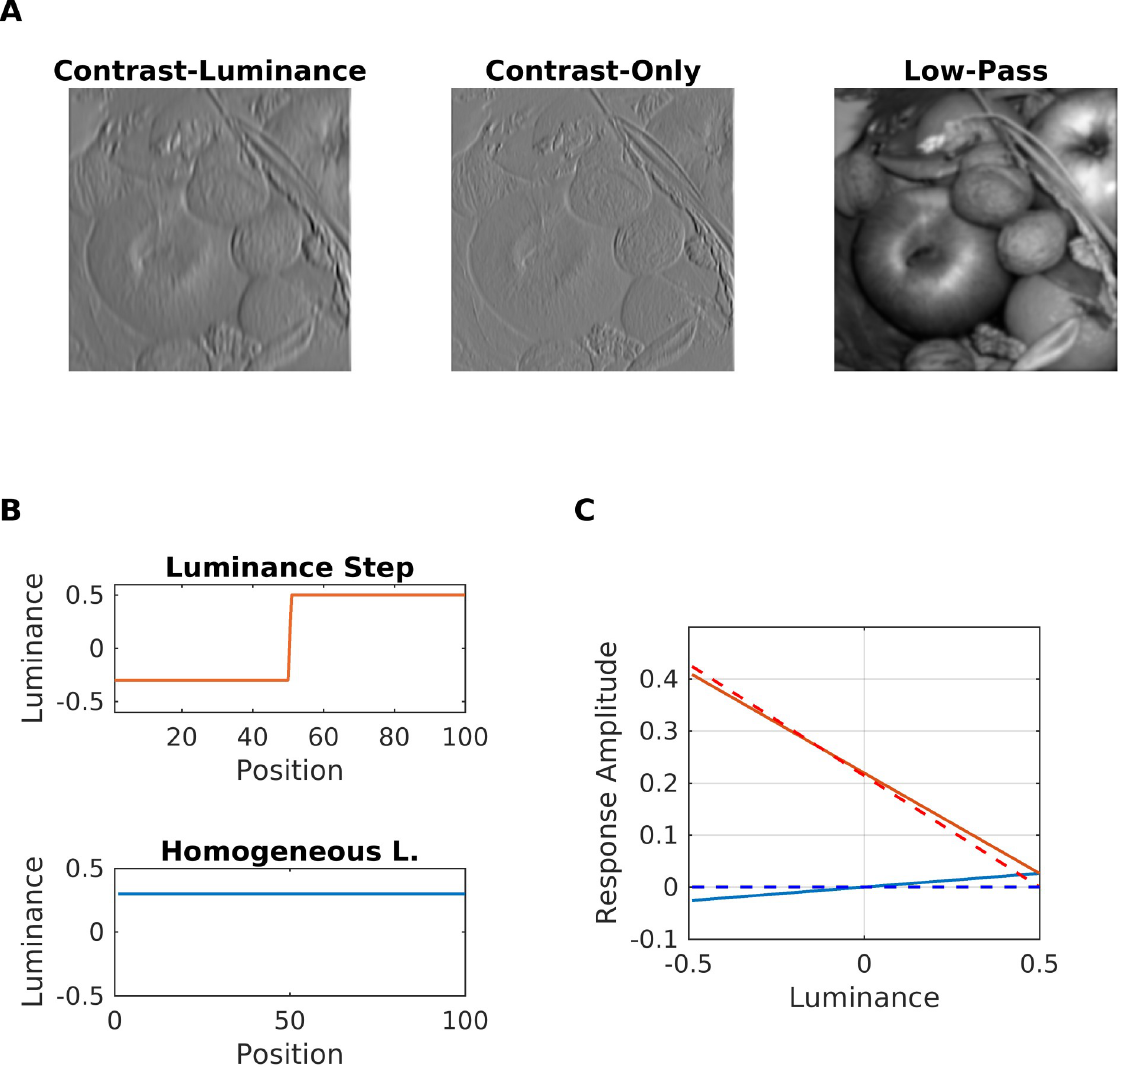
Fig 3. Sensitivity to contrast and luminance. (A) (left) Fruits filtered by a Contrast-Luminance filter g (Eq 1). (Middle) Fruits filtered by a Contrast-only filter g with the same orientation (Eq 1). (Right) Fruits filtered by a low-pass filter. (B) Example luminance step (values -0.3 to 0.5) and an example for a homogeneous region with luminance 0.3. (C) Responses (maximum) of Contrast-Luminance filters (solid lines) and Contrast-only filters (dashed lines) to the homogeneous region (red color) and the luminance step (blue color). For the luminance step, the lower luminance was increased from -0.5 to 0.5. Negative filter responses result from the use of negative input values.